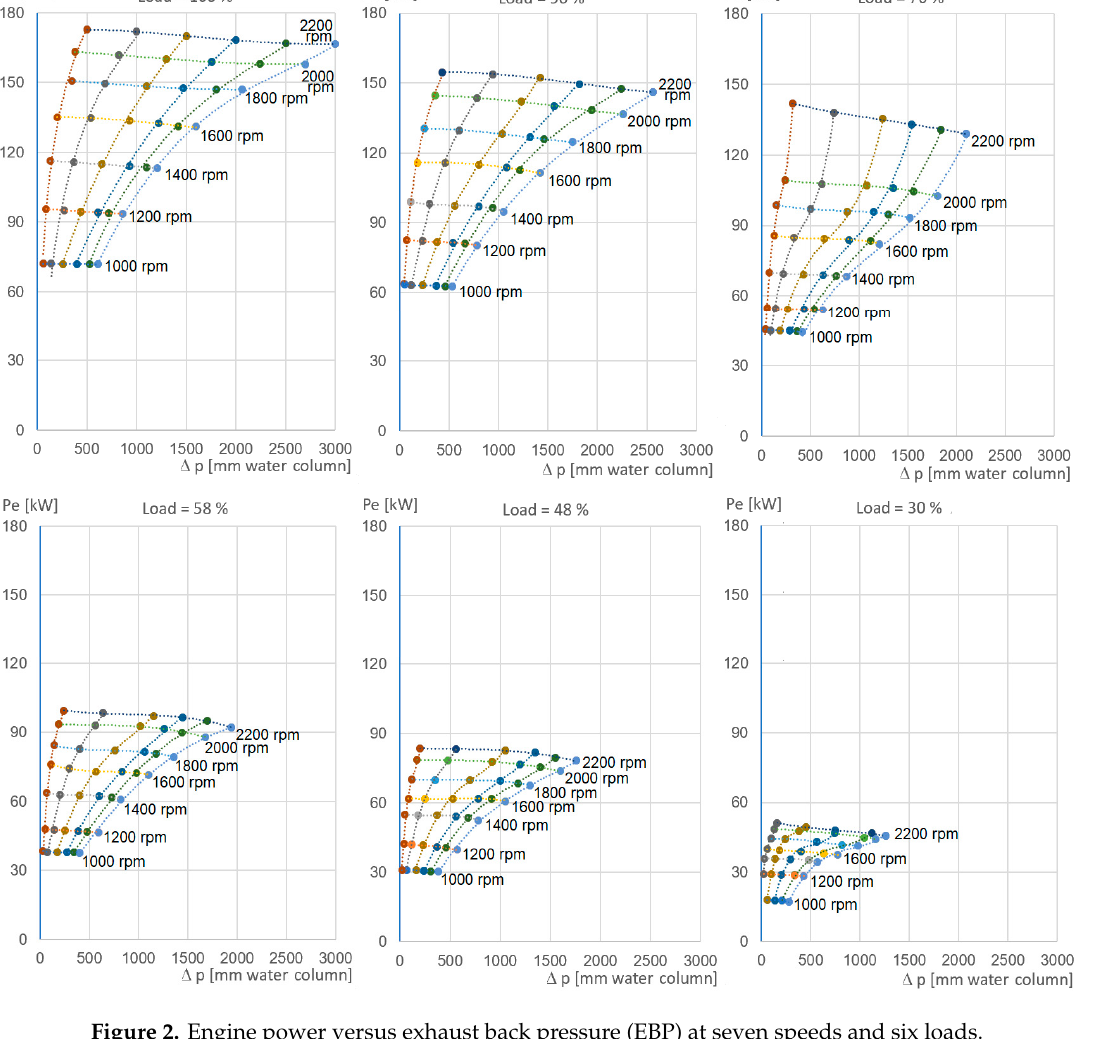
Figure 2. Engine power versus exhaust back pressure (EBP) at seven speeds and six loads.